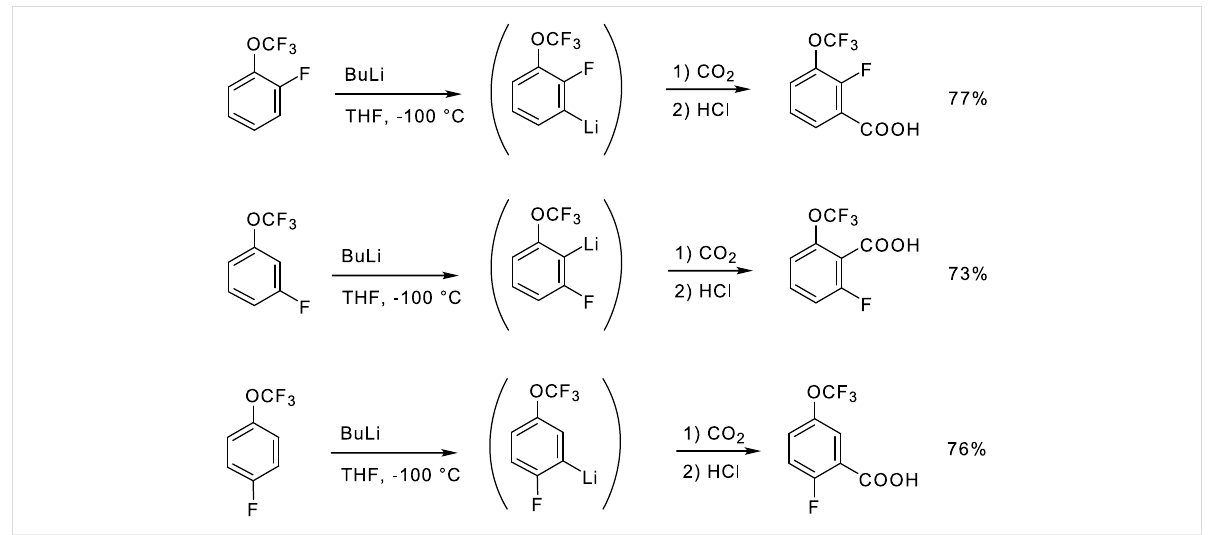
Scheme 16: Competition between -F- and -OCF 3 in Metalation reactions.